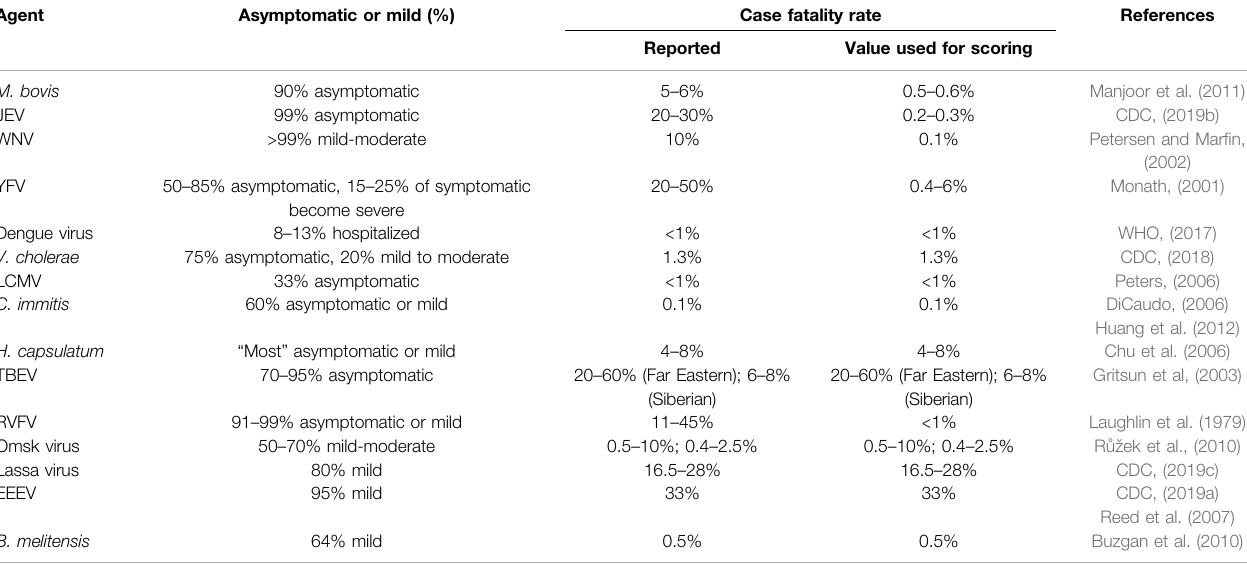
TABLE 4 | Agents causing large numbers of asymptomatic or mild